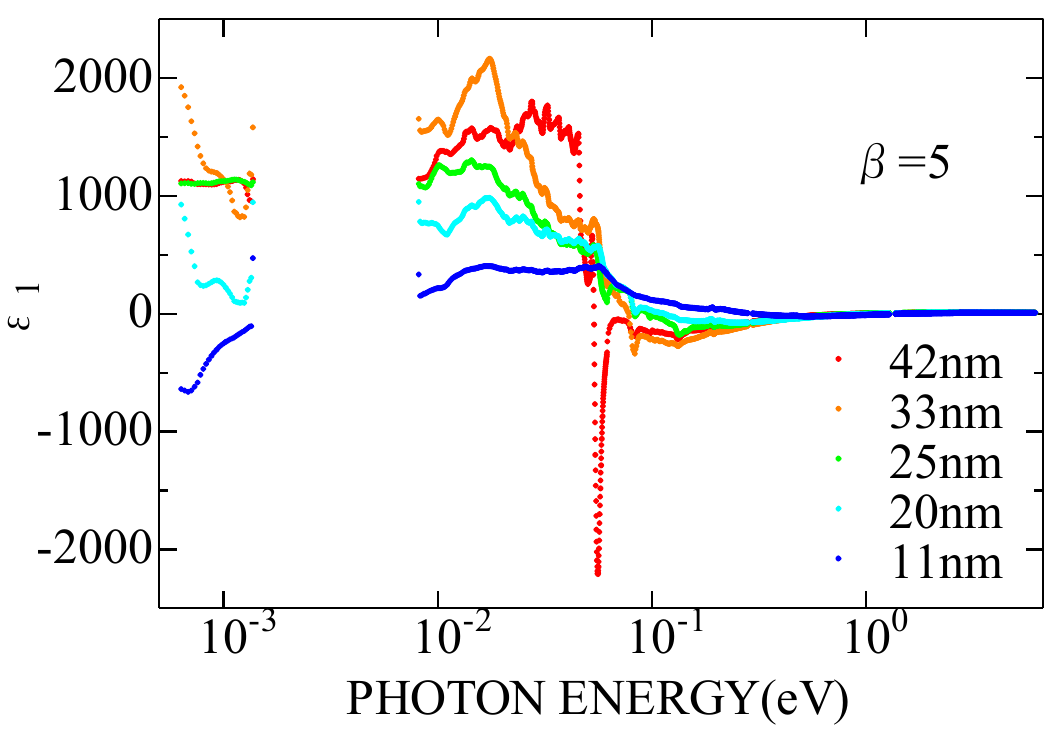
Figure 4: Dielectric constant spectra (real part) of NPG membranes on quartz substrates. The extrapolation exponent index of the reflectivity at high energy β =